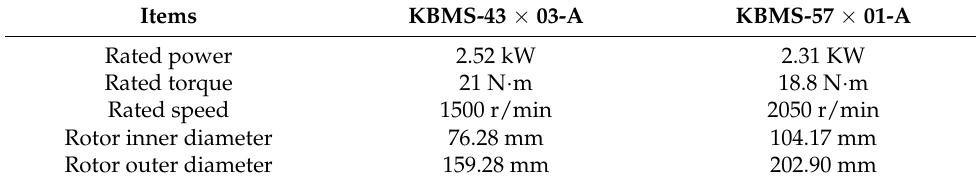
Table 7. Technical parameters of torque